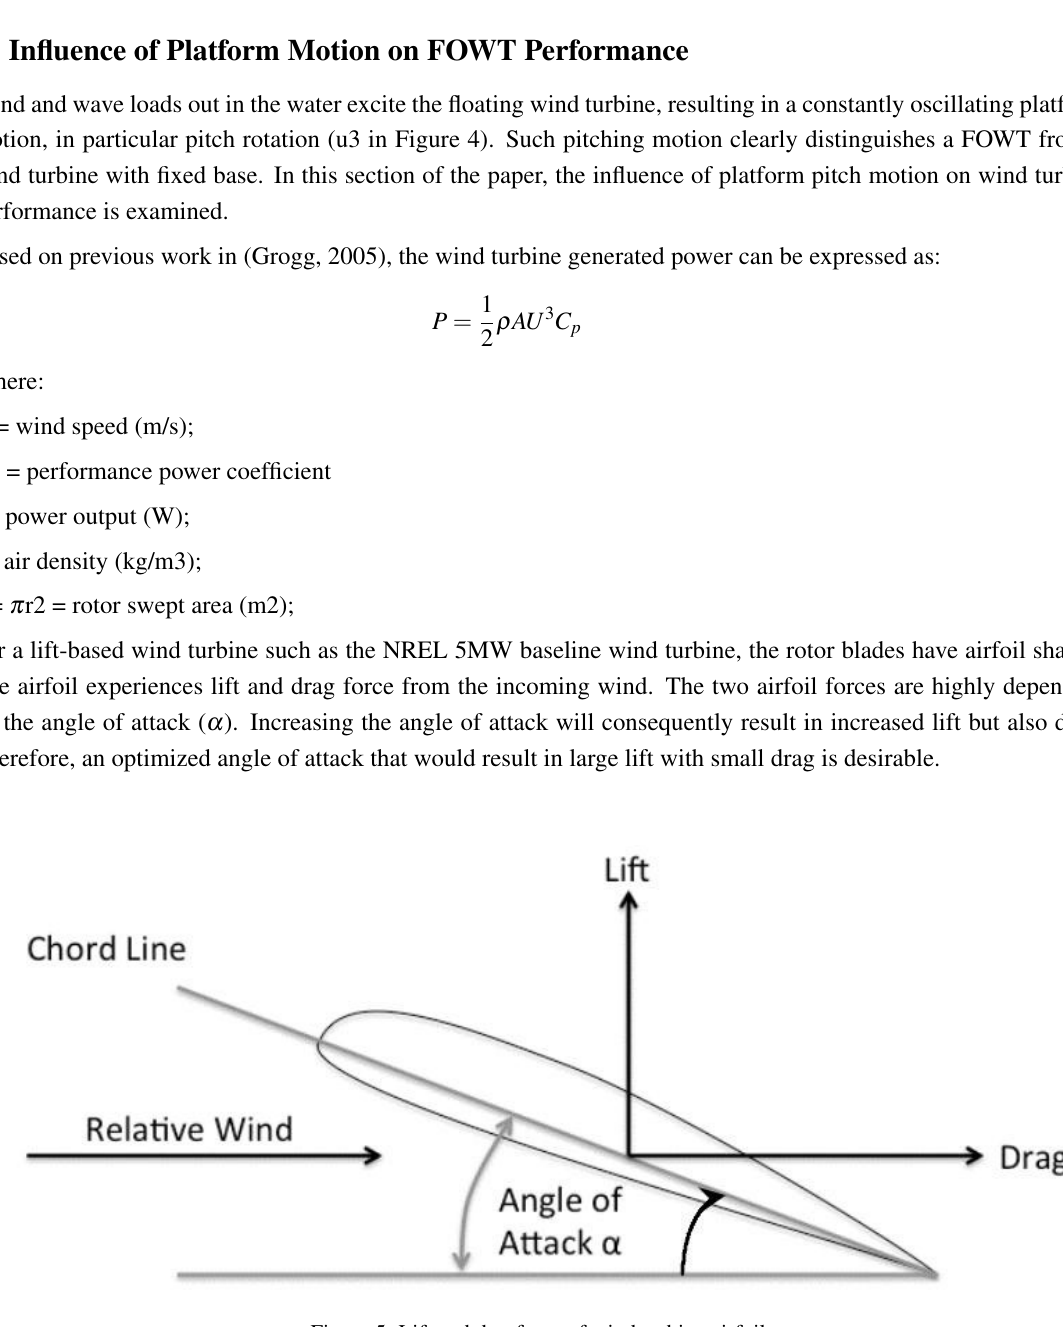
Figure 5. Lift and dragforce of wind turbine